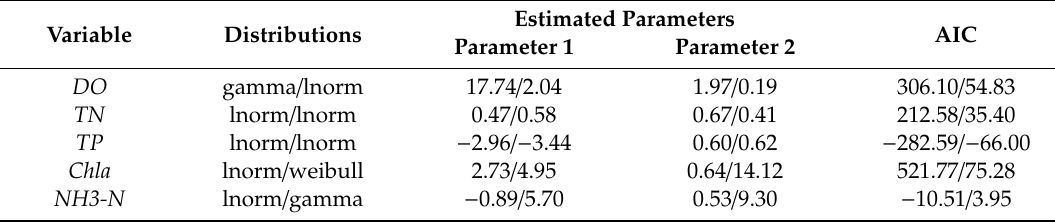
Table 3. The results of best fitted distribution to each variable along with their estimated parameters. The data before “ / ” represent results in the period of B-IRSN, and the data after “ / ’ represent results in the period of A-IRSN.